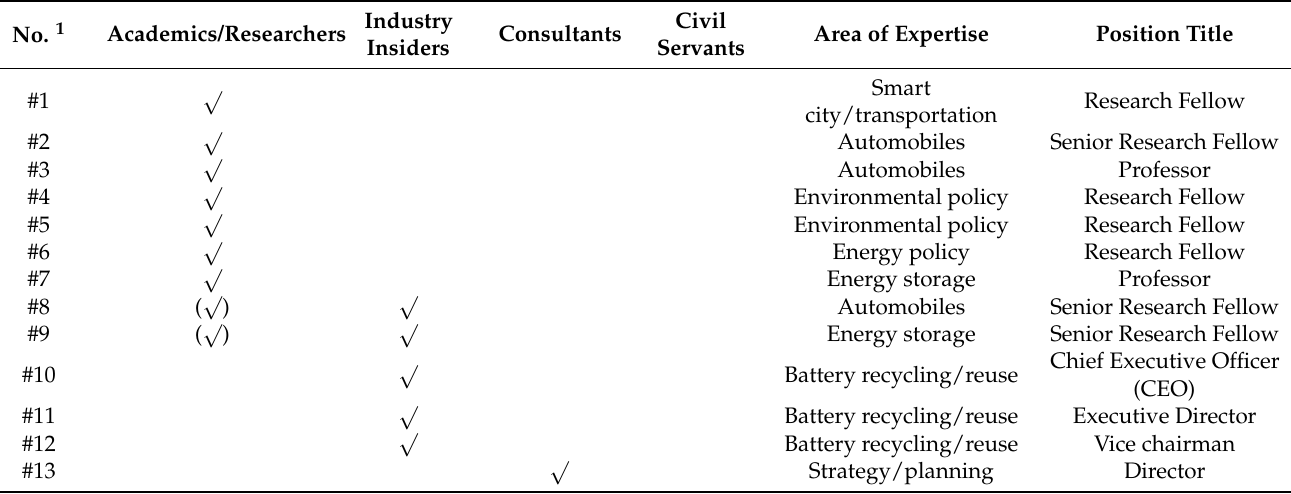
Table 2. An overview of the interviewed